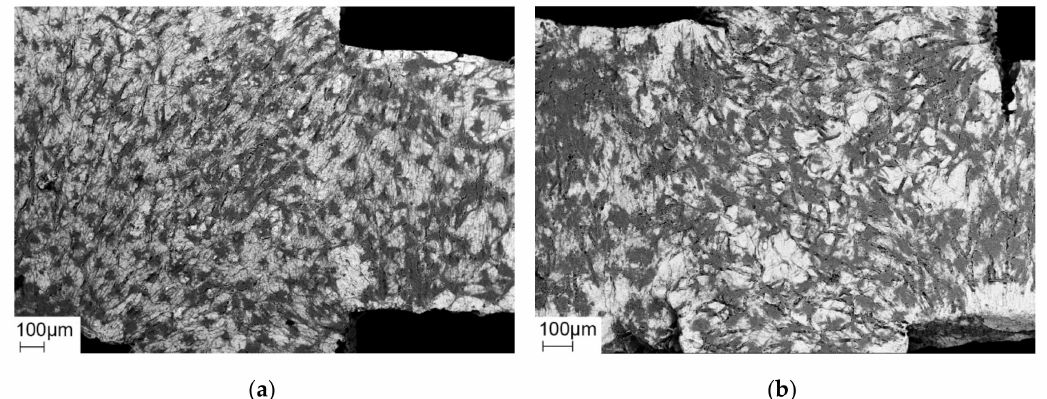
Figure 1. Scanning electron microscopic (SEM): dark cells are scattered all over the bright surface of the coated ( a ) and uncoated ( b ) grid.